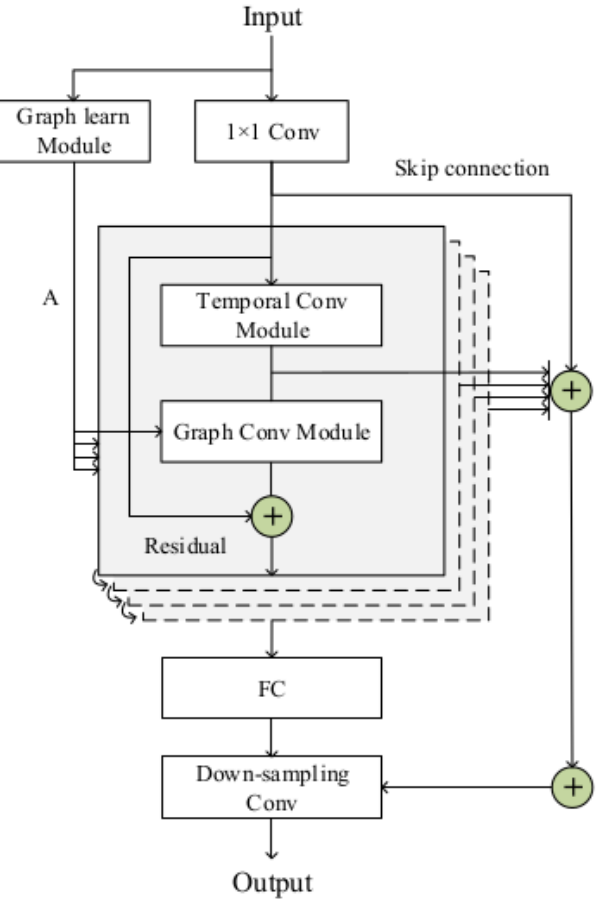
Figure 3. Model structure diagram of